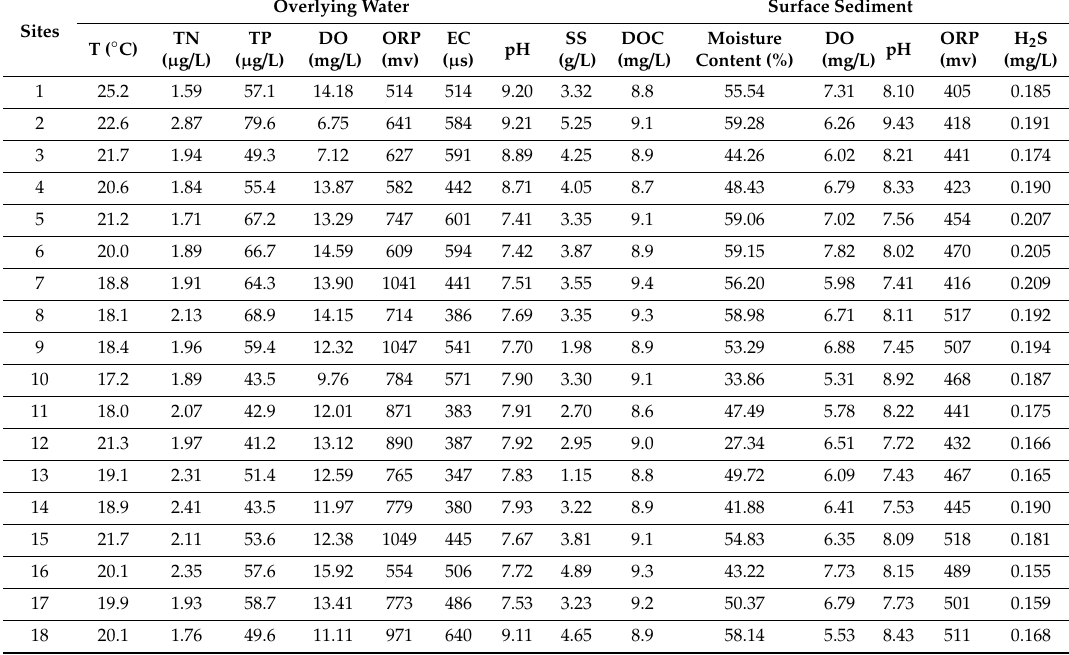
Table 1. The physiochemical properties of overlying water and surface